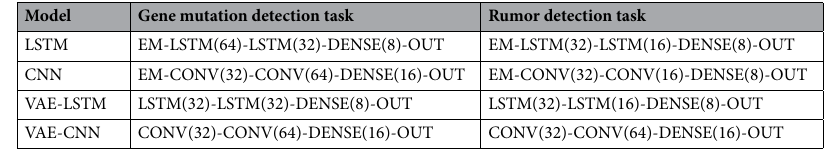
Table 10. Baselines’ architecture setup in both rumor detection task and gene classification with mutation detection